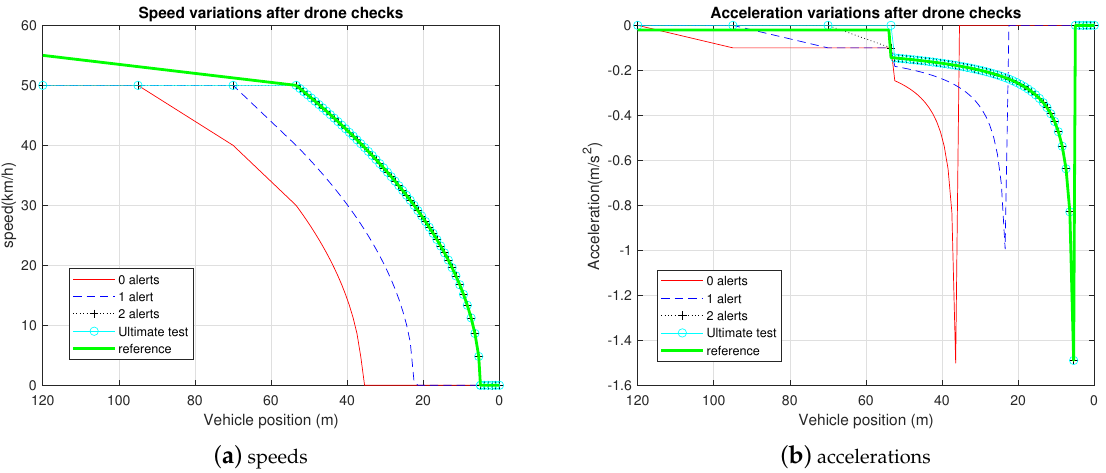
Figure 12. Speeds and accelerations of driver type 1, case of wet curved line.